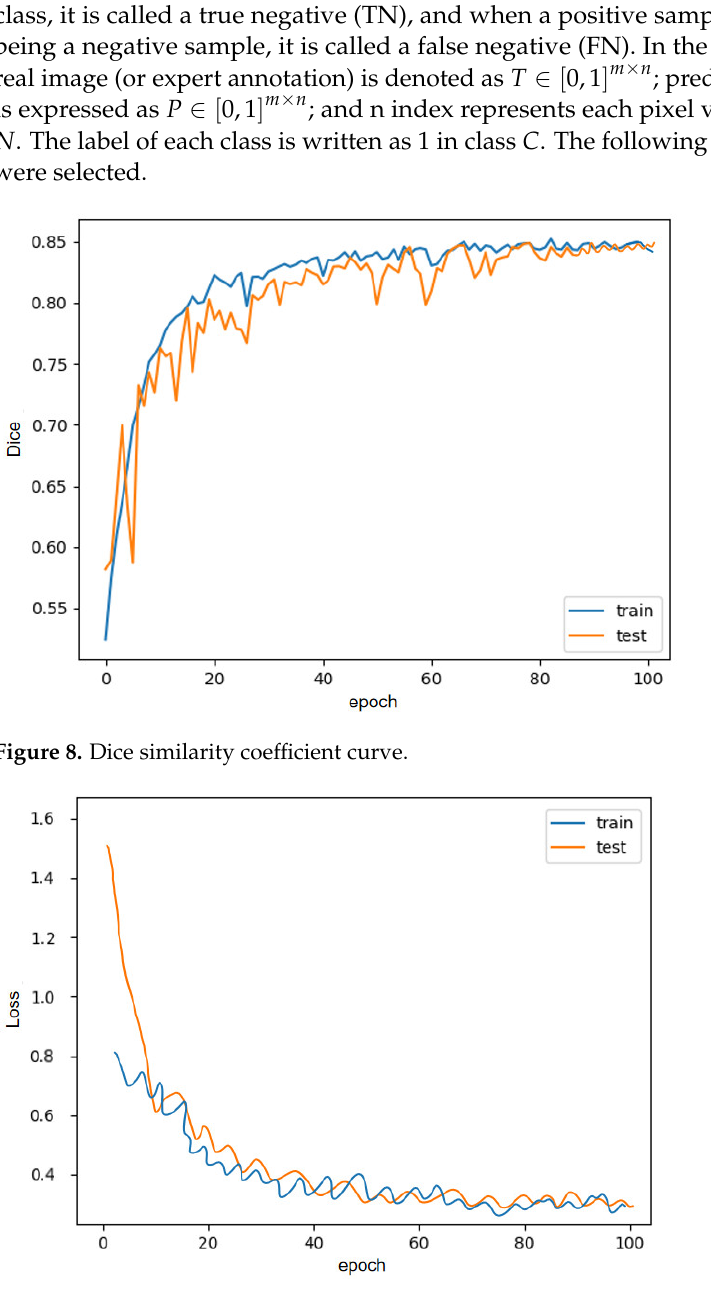
Figure 9. Loss function curve.